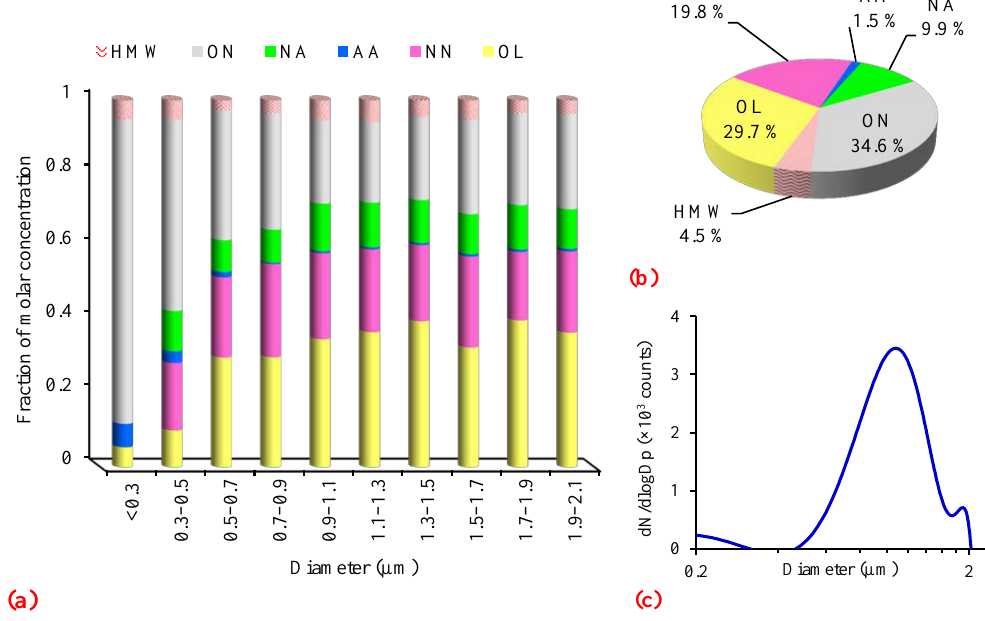
Figure 8. ATOFMS data analysis of (a) mole fraction of ozonolysed OL particles, under humidified conditions, as a function of particle size; (b) total particle composition as given by mole fraction for all size fractions; and (c) corresponding size distribution of the aged OL aerosol measured by